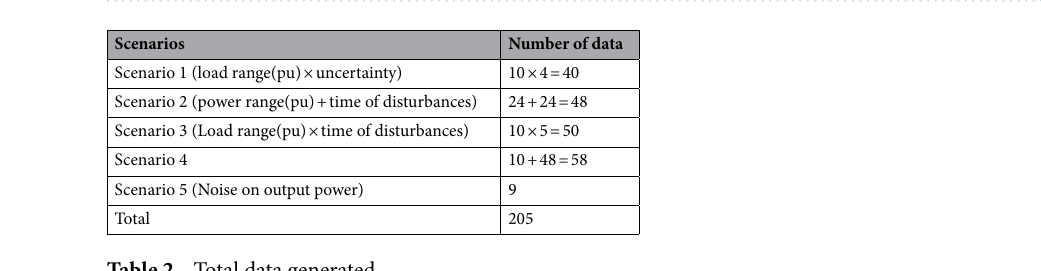
Figure 22. Scenario 5- Microgrid frequency response to white noise.